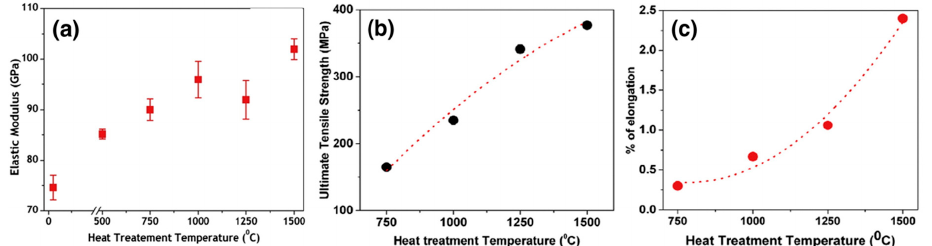
Figure 3. Micro-tensile test results showing ( a ) elastic modulus; ( b ) ultimate tensile strength; and ( c ) percentage of elongation of cold sprayed niobium deposits heat treated at different temperatures (adapted from reference [25] , with permission from © Elsevier).